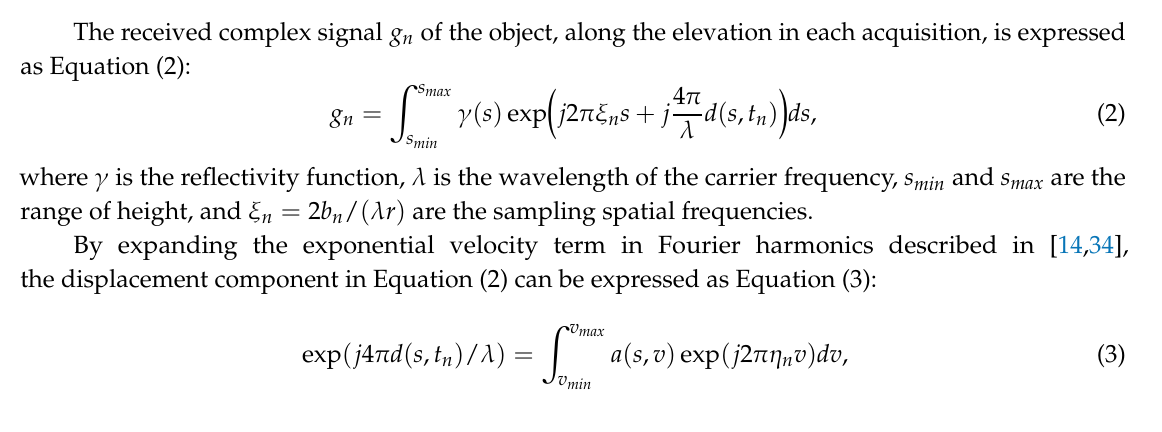
Figure 1. System geometry in the plane orthogonal to the orbit direction. Each satellite shows the positions of the acquisition antennas over repeated passes [26].